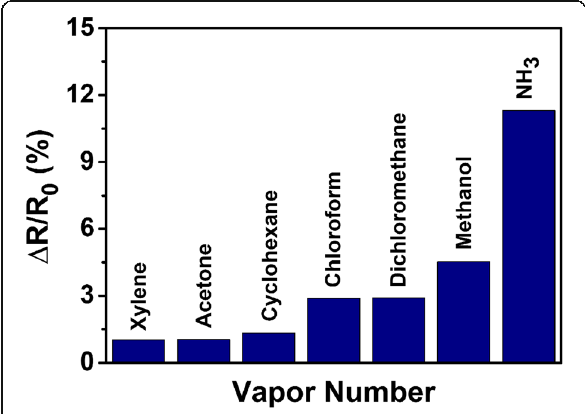
Fig. 8 Response of rHGO thin-film gas sensors to NH 3 compared with other analytes diluted to 1% of saturated vapor